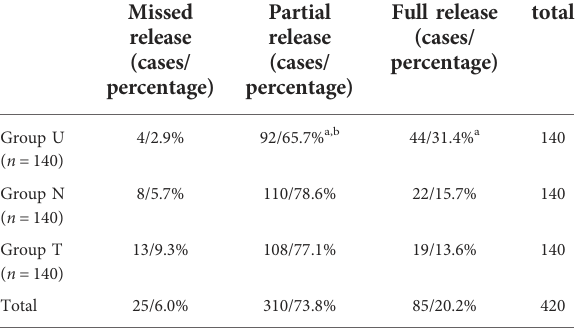
TABLE 2 The release length, actual length of A1 pulley and the percentage of released A1 pulley of three groups.